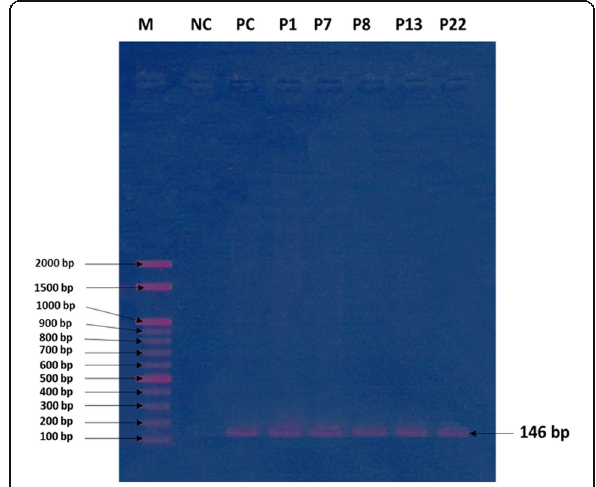
Fig. 1 PCR amplification of ecfx gene (146 bp) of P. aeruginosa isolates (lane M denoted size marker of 100 – 2000 bp, lanes NC and